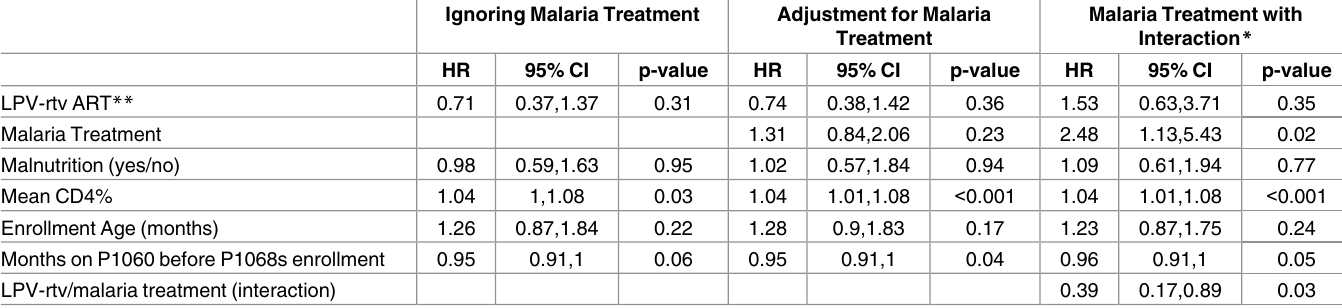
Table 2. As Treated Recurrent Events of Positive Blood Smears(BS) (Cox Model).